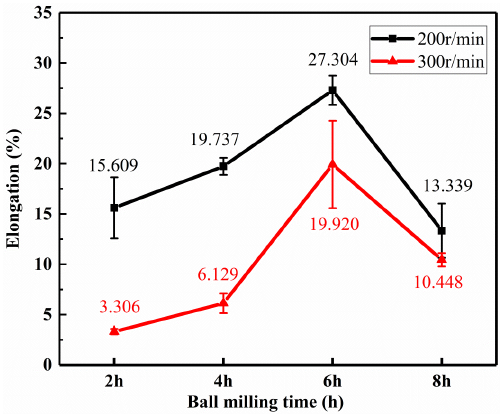
Figure 15. Elongation of the composite.